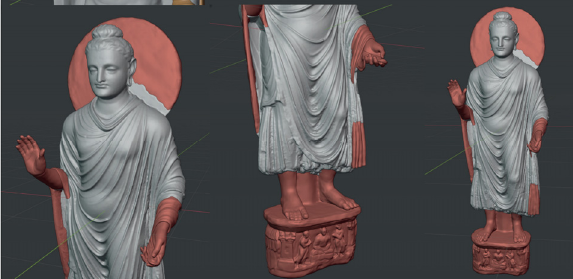
Figure 11 . Optimized 3D model of the Gandhāra Buddha derived from Metashape®